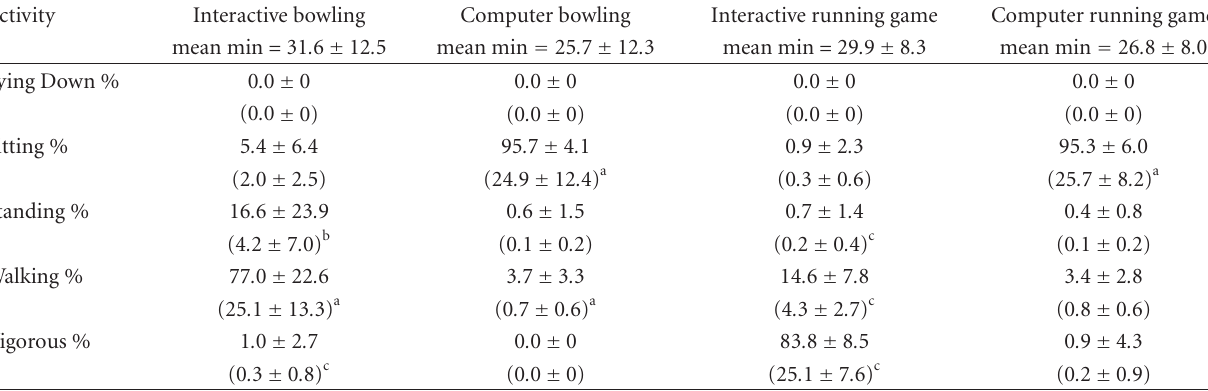
Table 2: Mean proportion of session time ± SD (and mean min ± SD) for activity levels during game type and mode. Activity